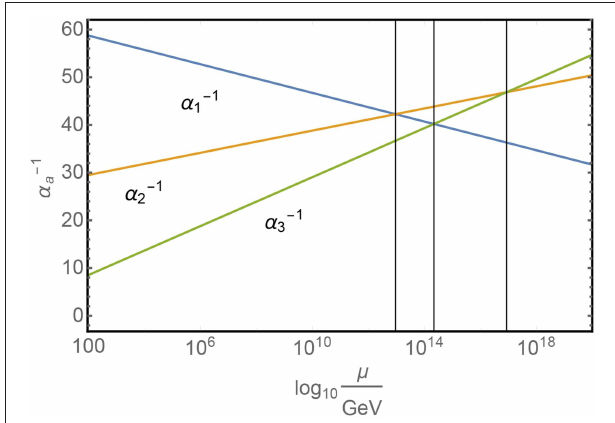
FIGURE 1 | Renormalization group flow of the standard model gauge